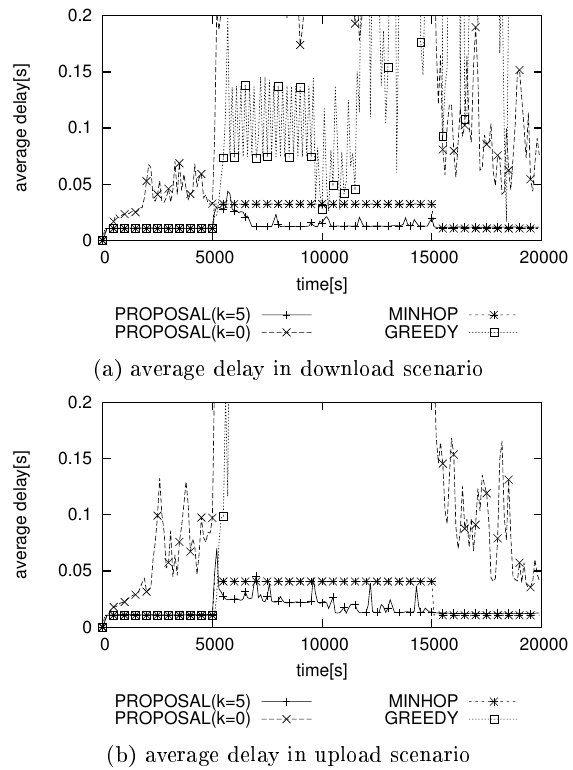
Figure 1: time courses of average